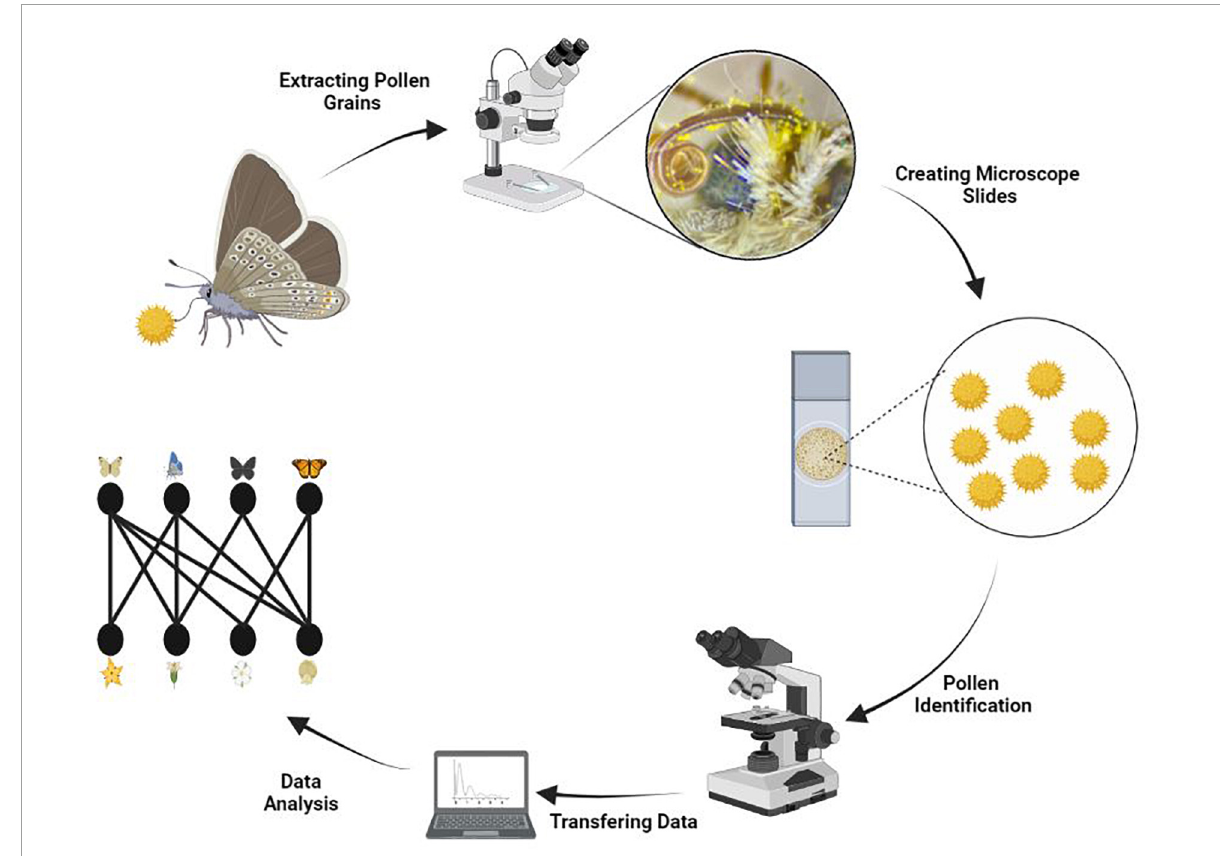
FIGURE2 Summary of pollen analysis method for plant-pollinator studies. Pollen grains are manually extracted from the insect specimen using an entomology pin under a microscope. The grains are then oriented and slide mounted for pollen identification via machine learning methods. The direct associations between insect and pollen are then combined with similar data from several specimens or several species collected at various spatial or temporal scales for examination via network analysis (or other downstream